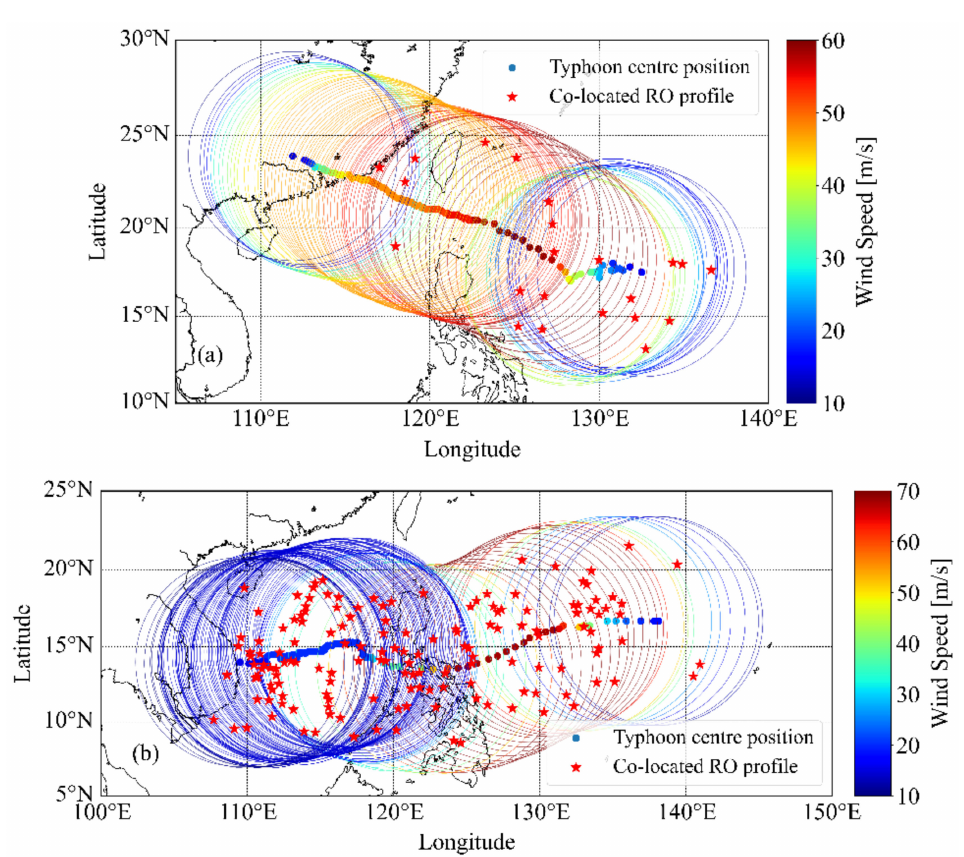
Figure 5. Examples of the co-location of typhoons and RO profiles (red stars) based on a 600 km radius. The time windows are 36 h and 12 h in ( a ) Usagi (TY5) with COSMIC and in ( b ) Goni (TY12) with COSMIC-2. Colors indicate the wind speed in